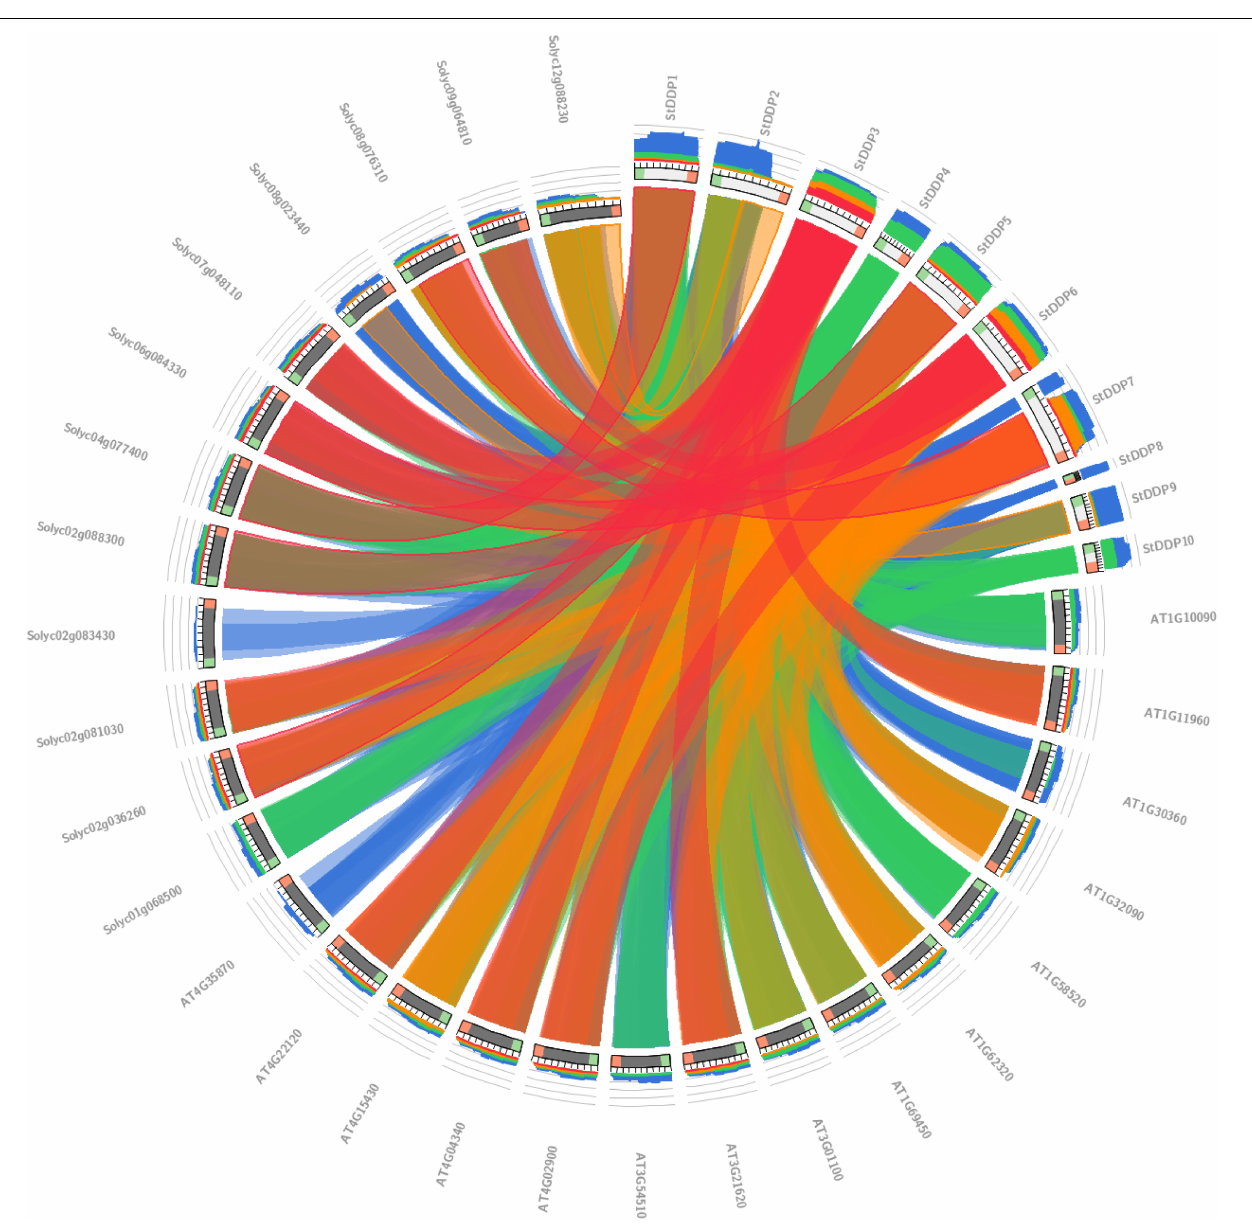
FIGURE 6 | Synteny analysis of DDPs among potato, tomato, and Arabidopsis genomes.